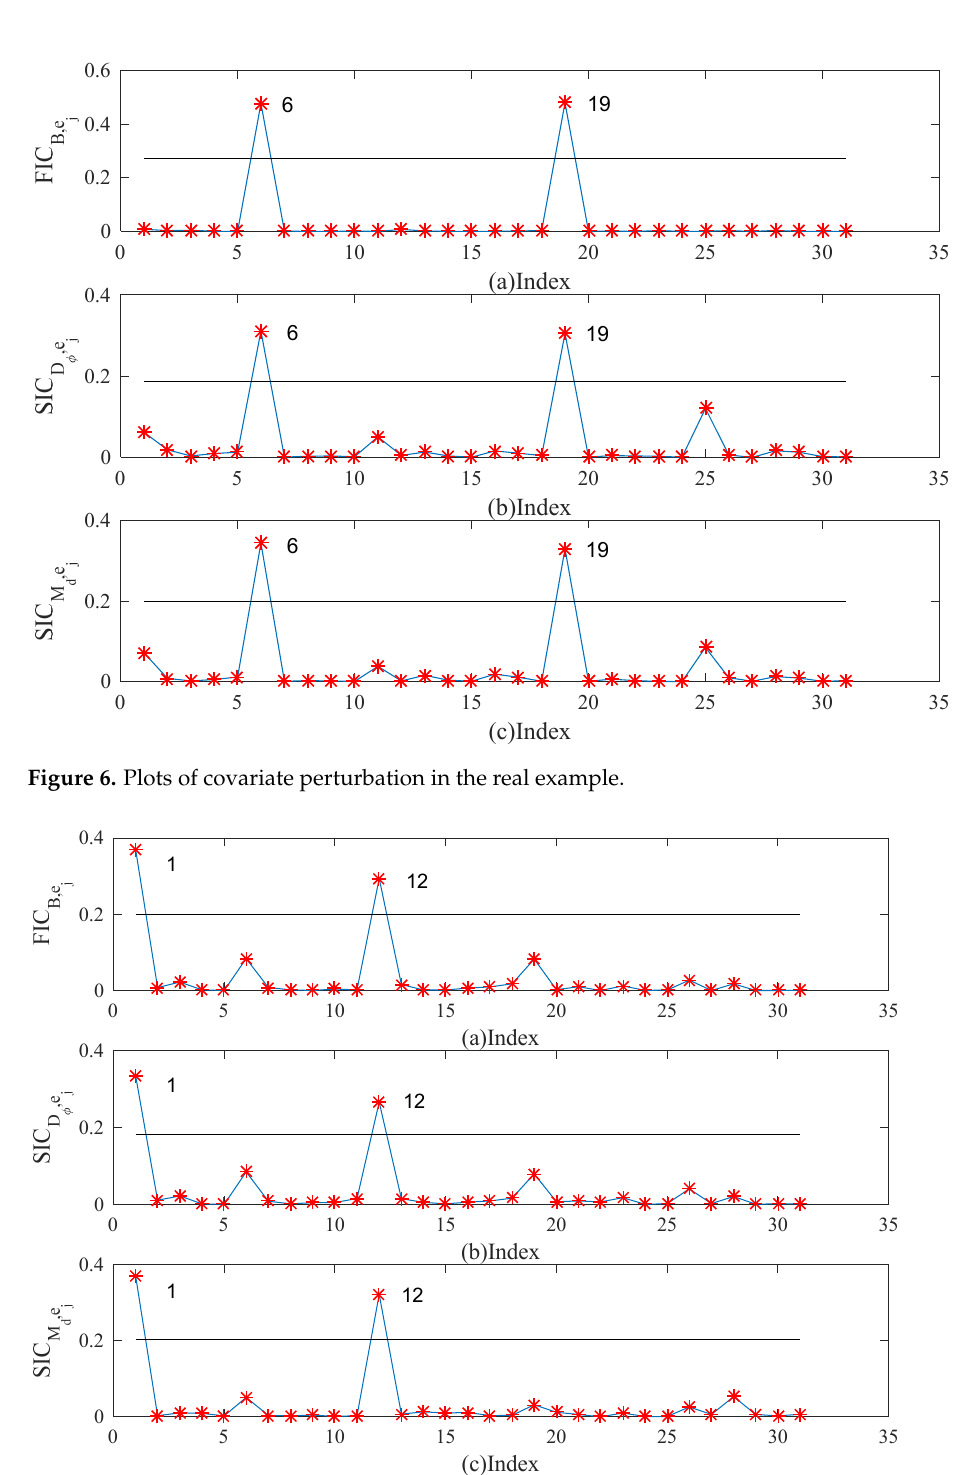
Figure 7. Plots of response variables perturbation in the real example.